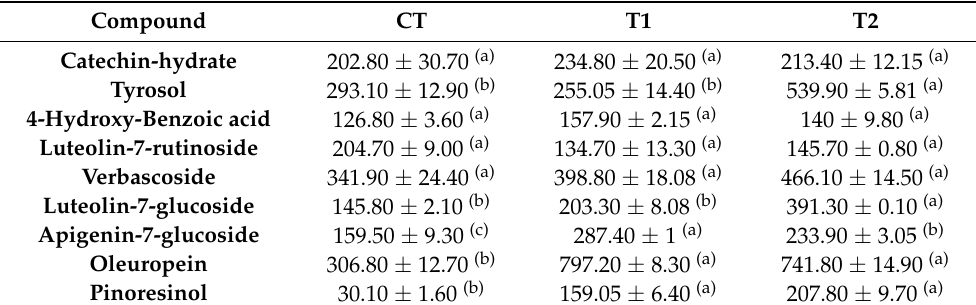
Table 2. Contents of phenolic compounds (mg kg − 1 ) in olive fruit samples after treatment with wastewater irrigation.